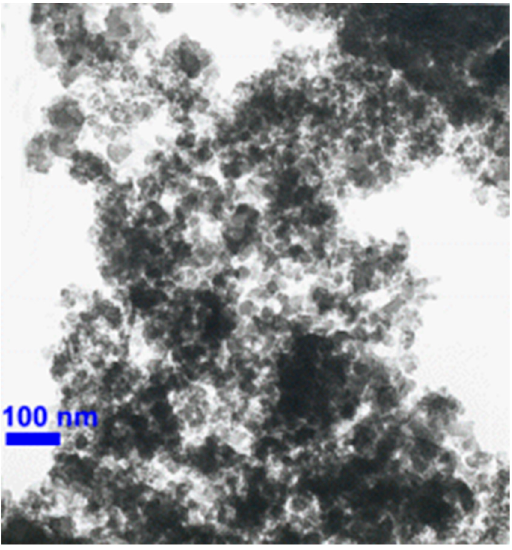
Figure 2. SEM image of SiO 2 nanoparticles (Courtesy: Nanostructured and Amorphous Materials, Inc., Houston, Pennsylvania, USA).